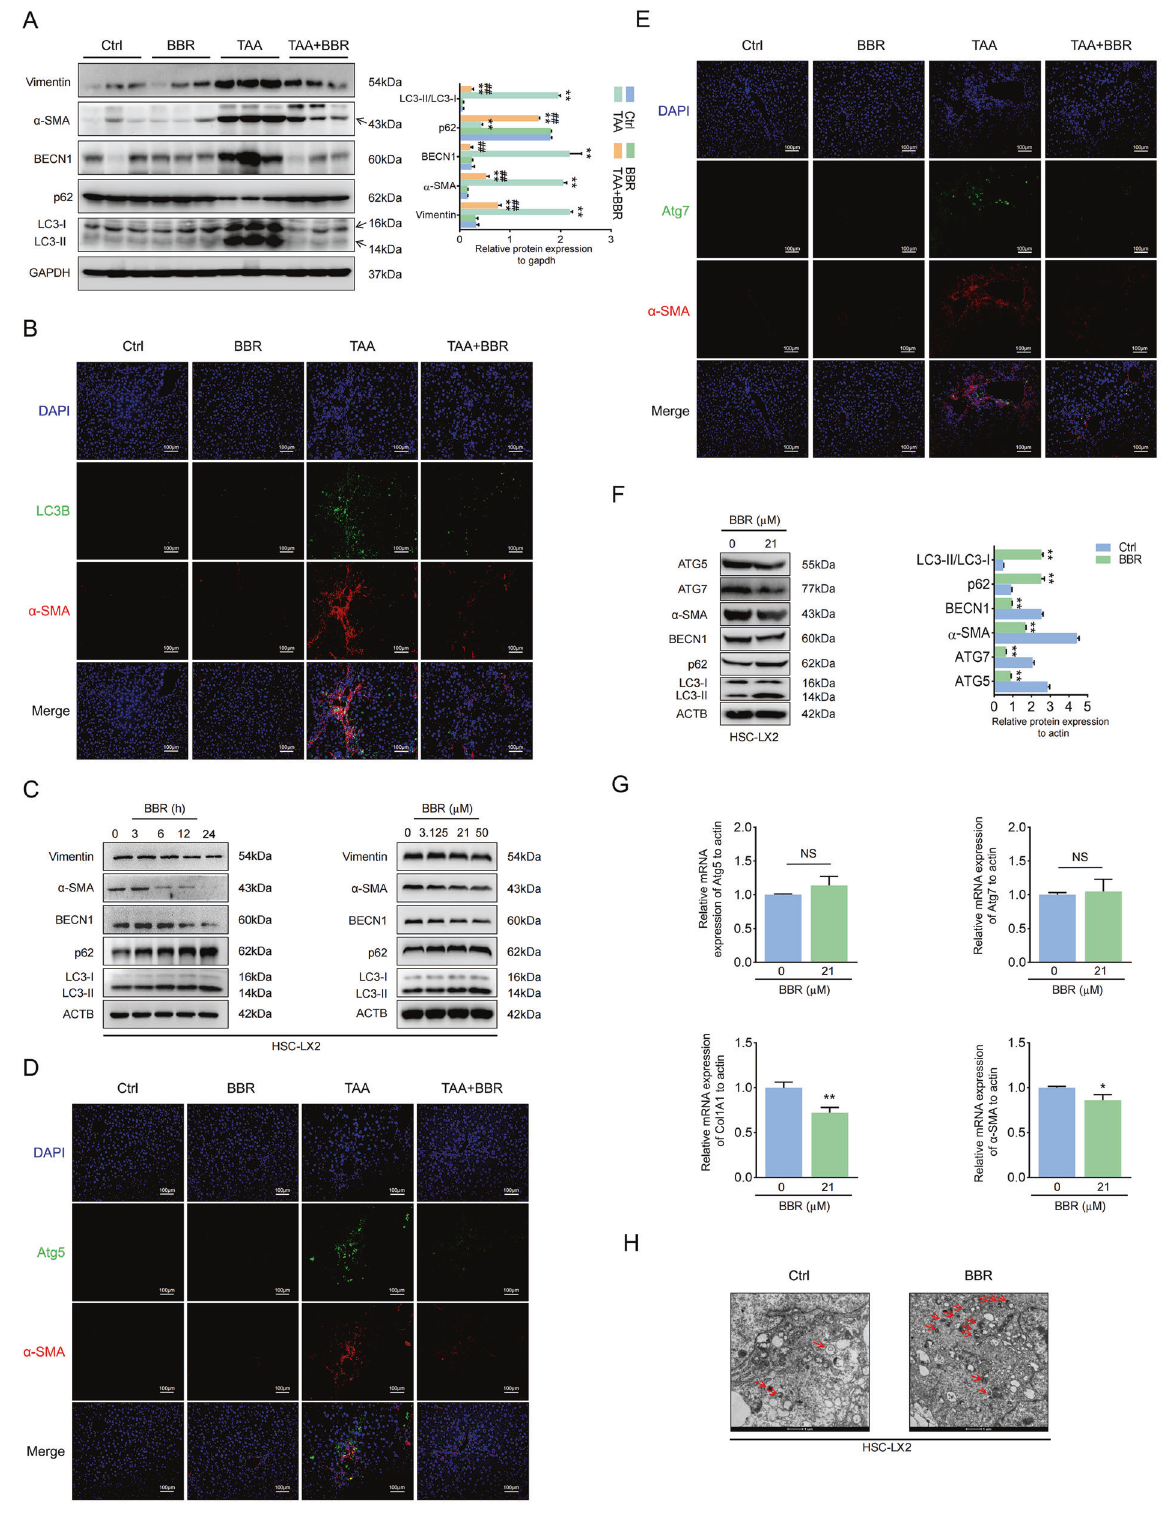
Fig. 4 Autophagy is involved in BBR-induced depression of HSC activation in liver fi brosis. A The expression levels of BECN1, p62, LC3B, vimentin, and α -SMA were detected by western blot in TAA-induced mouse liver fi brosis. B Double IF staining of α -SMA and LC3B. C Western blot revealed that BBR inhibited autophagy in HSC-LX2. D , E Costaining of α -SMA and Atg5 or Atg7. F , G HSC-LX2 cells were treated with or without BBR (21 μ M) for 24 h; protein expression of Atg5, Atg7, α -SMA, LC3B, and p62 and the relative mRNA levels of Atg5, Atg7, COL1A1, and α -SMA were assayed by western blot and qPCR. H HSC-LX2 cells were treated with or without BBR (21 μ M) for 24 h; transmission electron microscopy ultrastructural features of autophagosomes are presented. The results are expressed as mean ± SD. Data are representative of three independent experiments; n = 3 – 6 in every group; Scales: 1 or 100 μ m. Representative photographs are shown. Compared with the control group, * P < 0.05, ** P < 0.01; compared with the model group, ## P < 0.01. NS, not signi fi cant. Cell Death Discovery (2021)